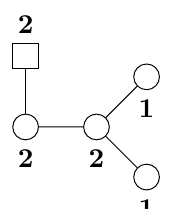
Figure 9 . The Coulomb branch of this quiver is isomorphic to the so (8 ; C ) next-to-minimal nilpo- tent